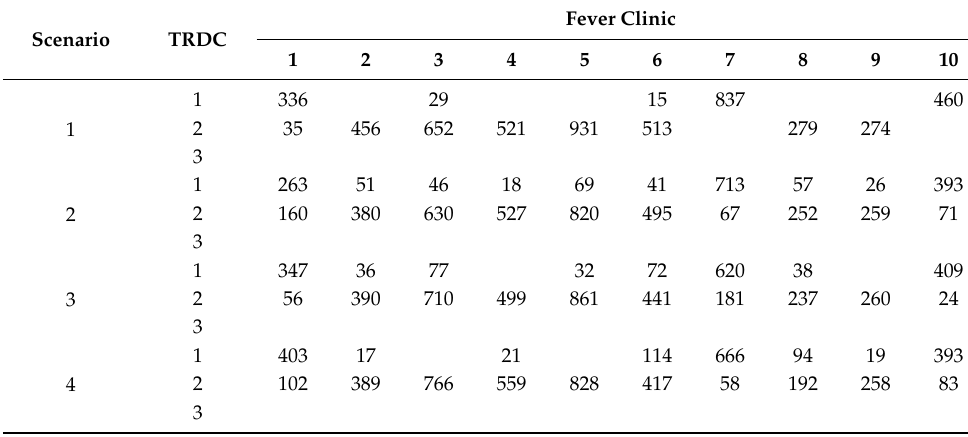
Table 7. Relief commodities sent from established TRDCs to fever clinics.